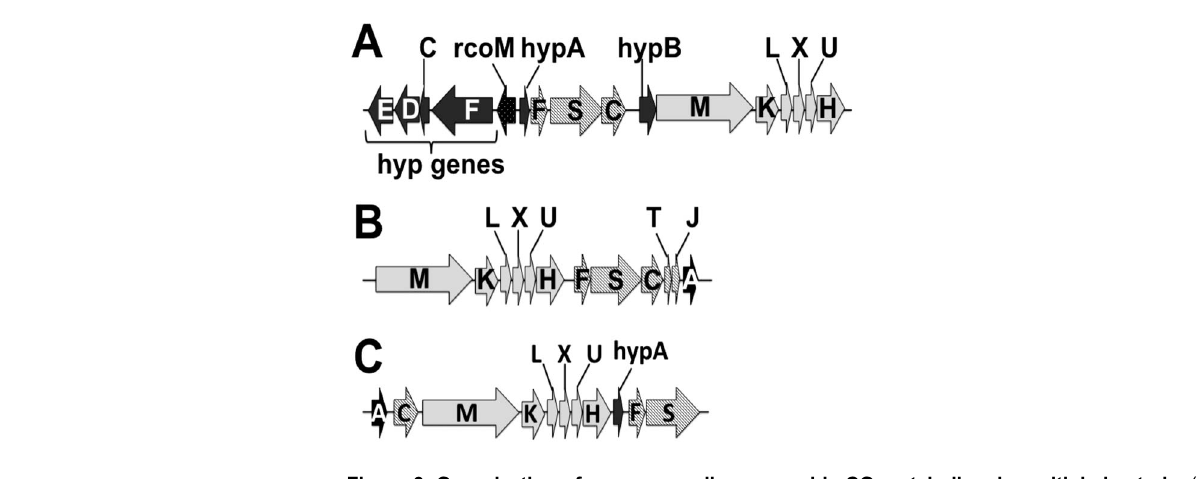
Figure 3. Organization of genes encoding anaerobic CO metabolism in multiple bacteria. (A) Gene structure of CO metabolism genes in Rubrivivax gelatinosus CBS. The hyp genes putatively responsible for coo hydrogenase maturation are clustered among the coo CODH and hydrogenase genes. The gene encoding RcoM, the putative transcription factor for the coo CODH and hydrogenase genes is located among the hyp genes within this cluster of CO metabolism genes. (B) Gene structure of CO metabolism genes in Rhodospirillum rubrum . The cooA gene, encoding the CooA CO-responsive transcription factor, directly follows the CODH genes. (C) Gene structure of CO metabolism genes in Carboxydothermus hydrogenoformans . C. hydrogenoformans has five CODH complexes, but the genes for only one CODH are co-located with the genes for an energy-conserving hydrogenase [36]. The cooA and hypC genes precede the cooMKLXUH hydrogenase genes, which are followed by hypA and the cooFS CODH